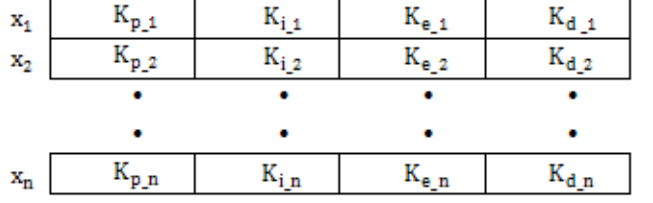
Figure 13. Structure of position vector of PSO for fuzzy PID controller tuning.